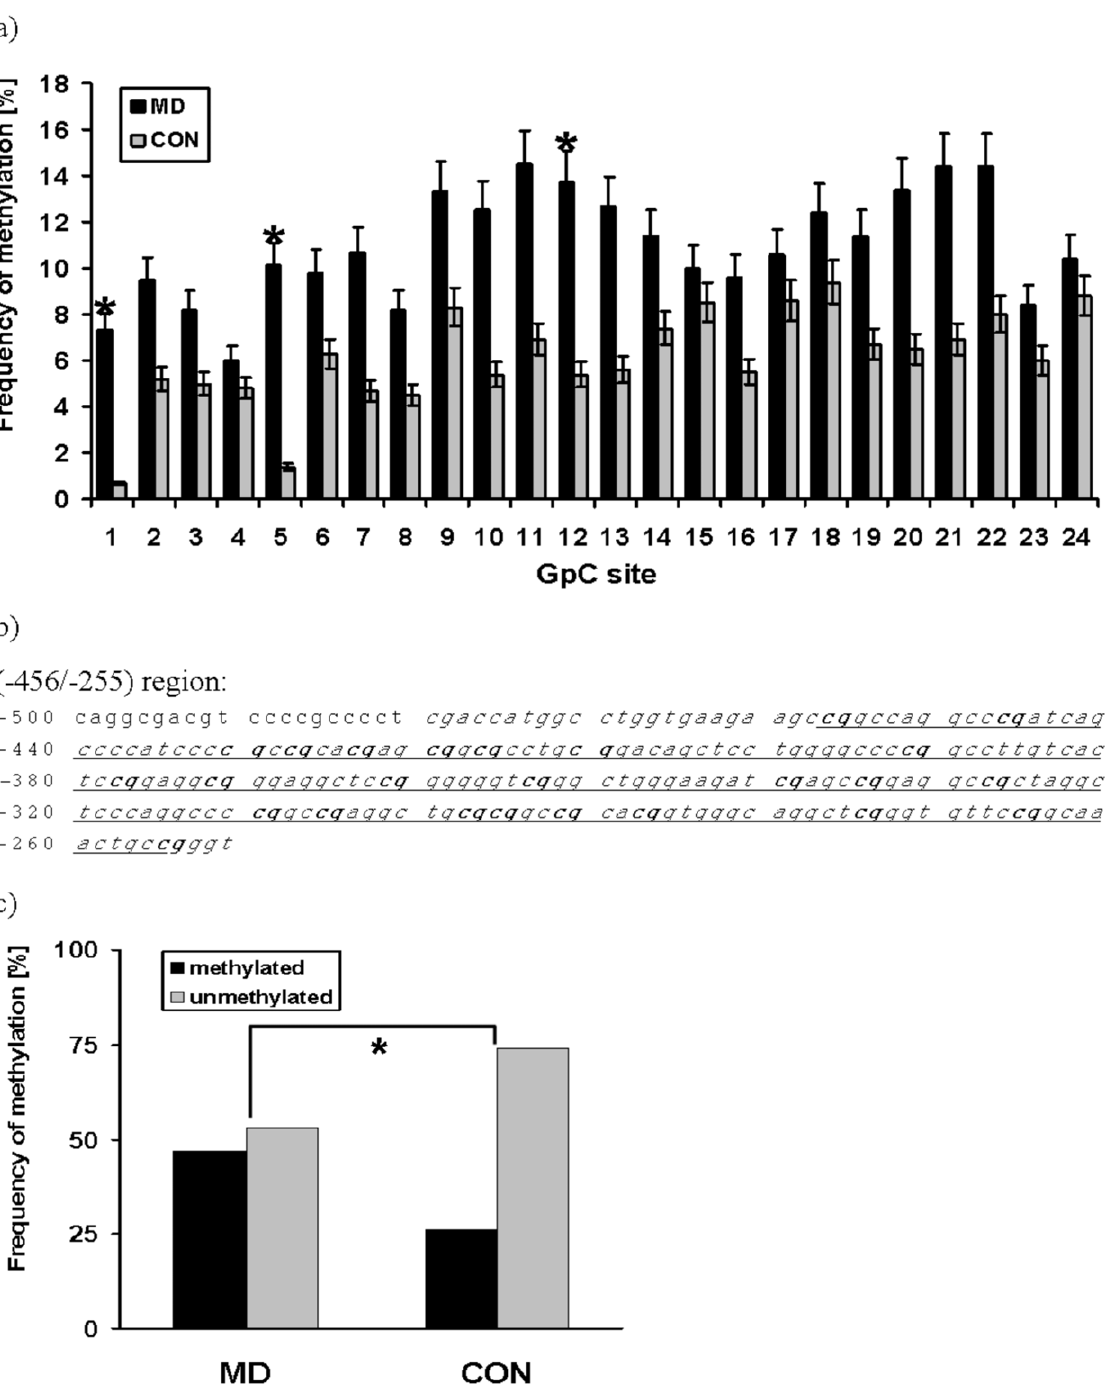
Figure 1. Frequency of DNA methylation in the investigated ACE promoter region. (a) Frequency of DNA methylation at 24 CpG sites, located in the ( 2 456/ 2 255) region of the ACE gene in depressive patients (MD) and healthy controls (CON); *: p , 0.05 ( x 2-test). (b) Sequence of the ( 2 456/ 2 255) region (italic, underlined) including the 24 investigated CpG sites (bold). (c) Frequency of methylation and non-methylation at the 24 CpG sites, located in the ( 2 456/ 2 255) region of the ACE gene in depressive patients (MD) and healthy controls (CON). Patients have a significantly higher methylation status than the healthy controls (p=0.008, x 2=7.1, df=1). *: p , 0.05 ( x 2-test). doi:10.1371/journal.pone.0040479.g001 pattern as in leukocytes of controls, but with somewhat higher Further statistical analysis revealed no correlation between number of methylated CpG sites or methylation frequency and frequency (figure 2). In average, methylation levels of 18% (over all 24 CpG sites) in cortex (mean: 17.8% 6 19.9%) and 13% in age, gender or post mortem interval in the analyzed patient-, hippocampus (mean: 12.6% 6 14.0%) could be measured. control- and post mortem samples.